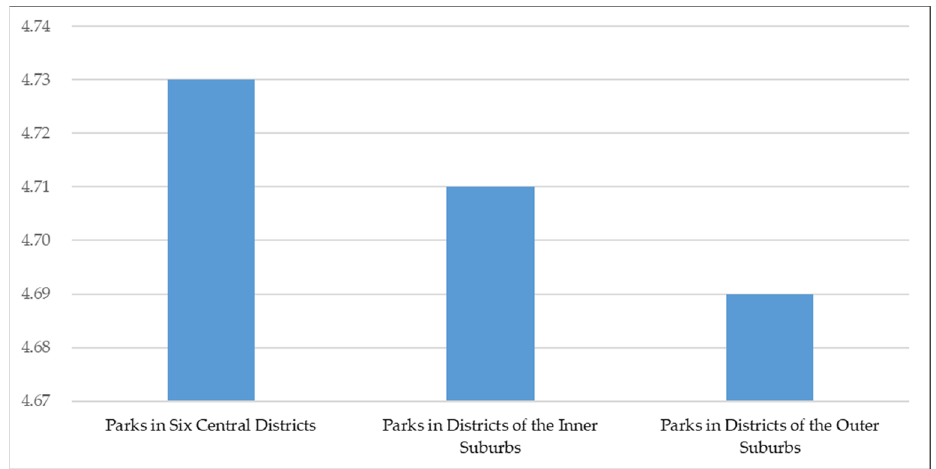
Figure 11. The average stars of riverside parks in different